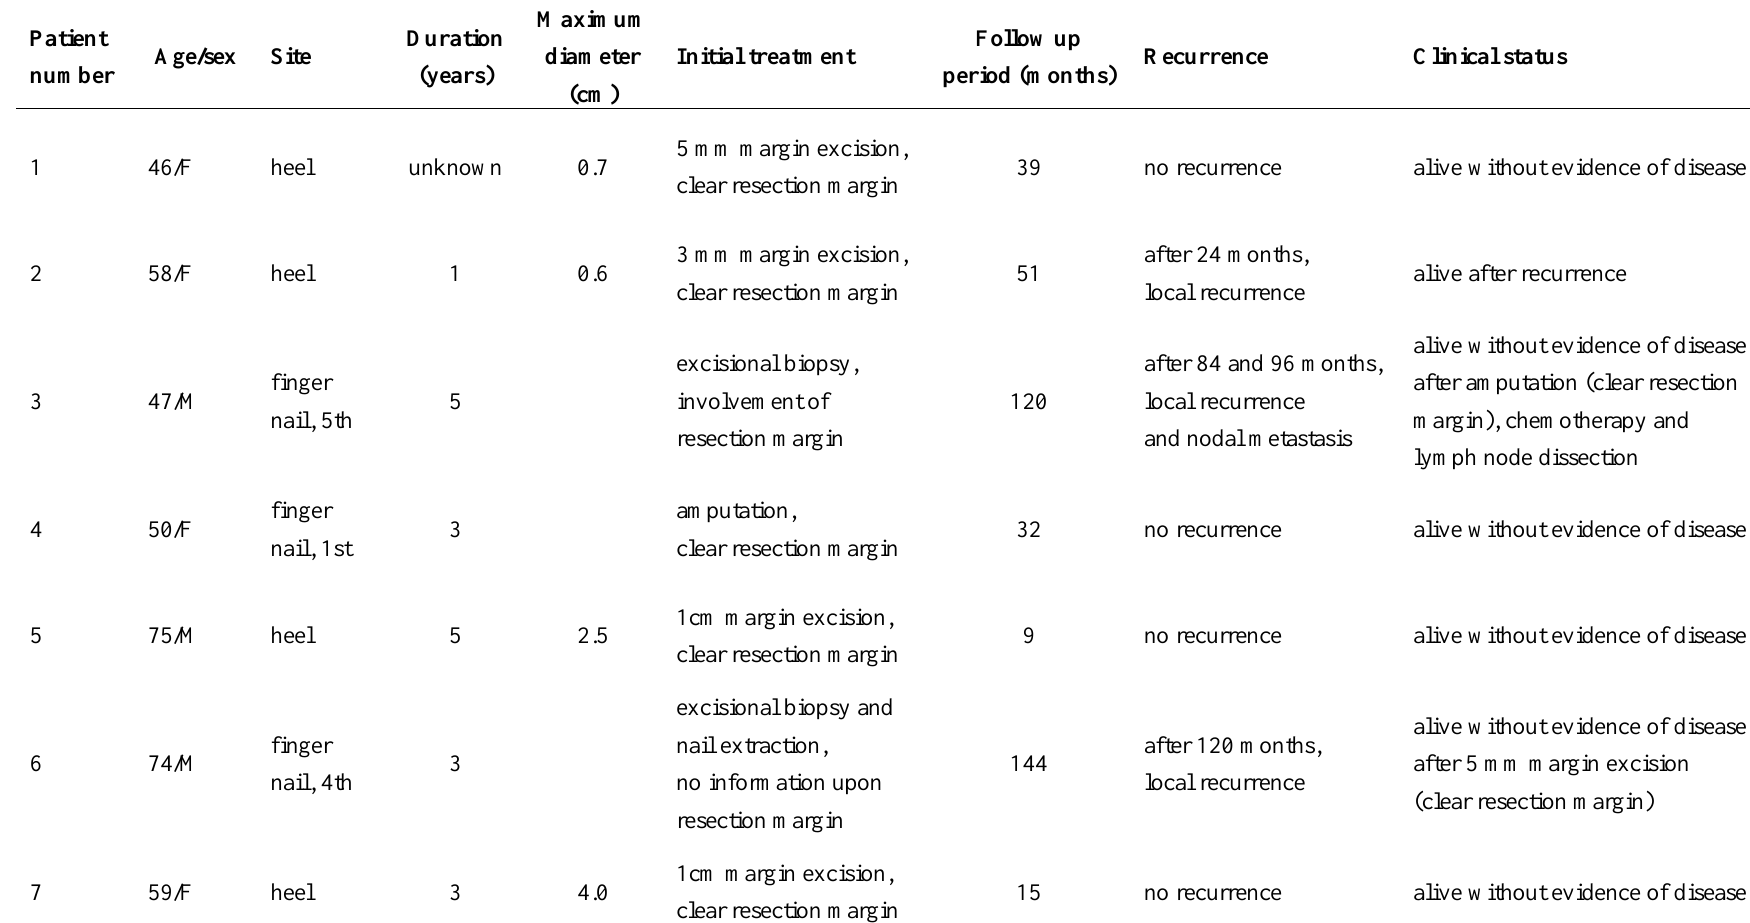
Table 1. Summary of the